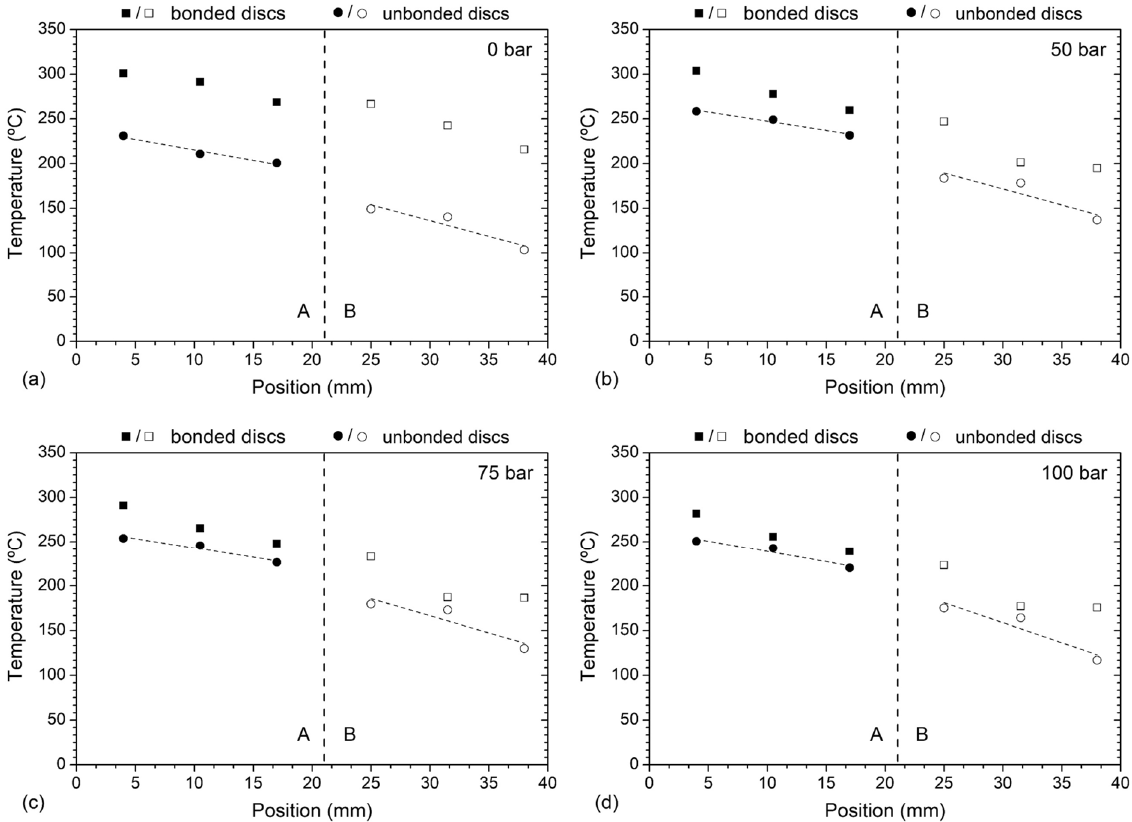
Figure 7. Temperature profiles at the interface between the unbonded (A/B) and bonded (A.B.) configurations at the following contact pressures: ( a ) 0 bar, ( b ) 50 bar, ( c ) 75 bar, and ( d ) 100 bar.